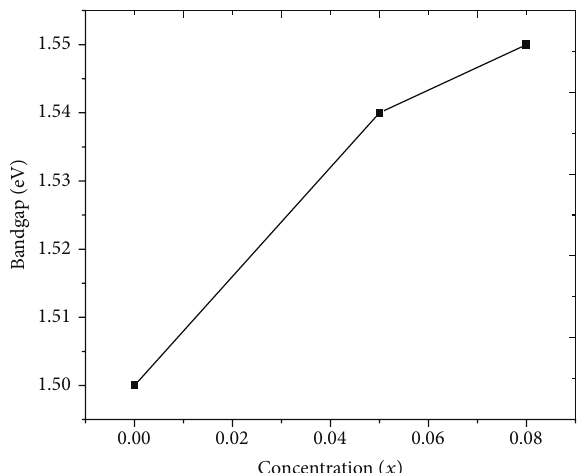
Figure 5: Variation of band gap of Cd 1−𝑥 Co 𝑥 Te powders with Co concentration.